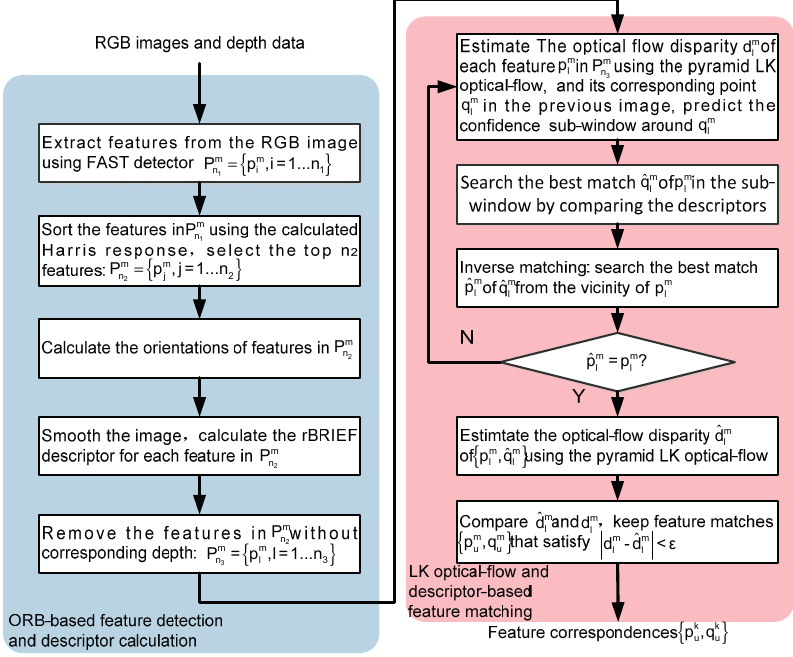
Figure 4. Process flow of the OFC-ORB feature detection and matching